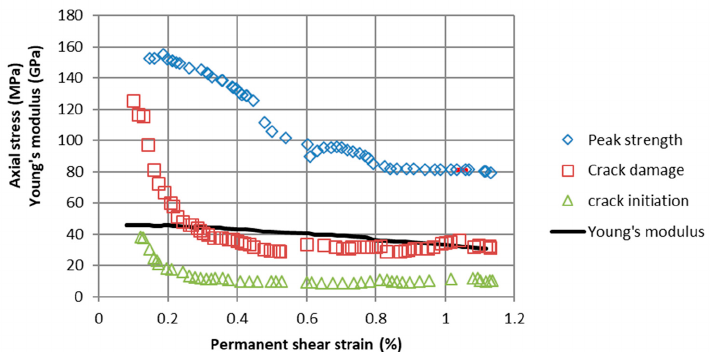
Figure 3. Evolution of peak strength, crack initiation, crack damage stresses and Young’s modulus from uniaxial compression test on LdB granite (adapted from [12]).